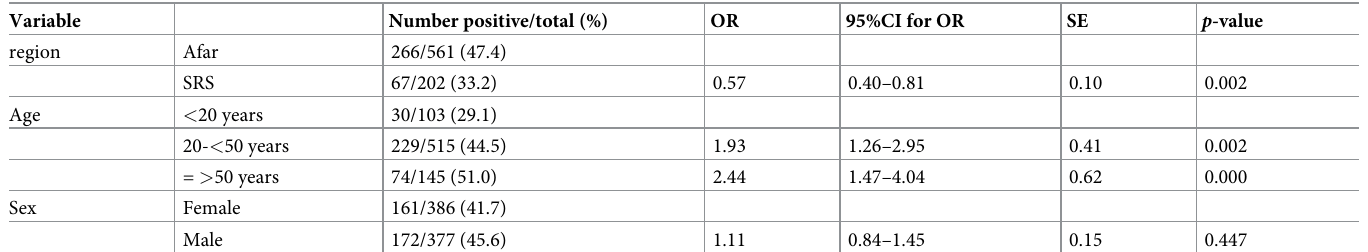
Table 7. Univariate analysis in people with random effect on household (GEE